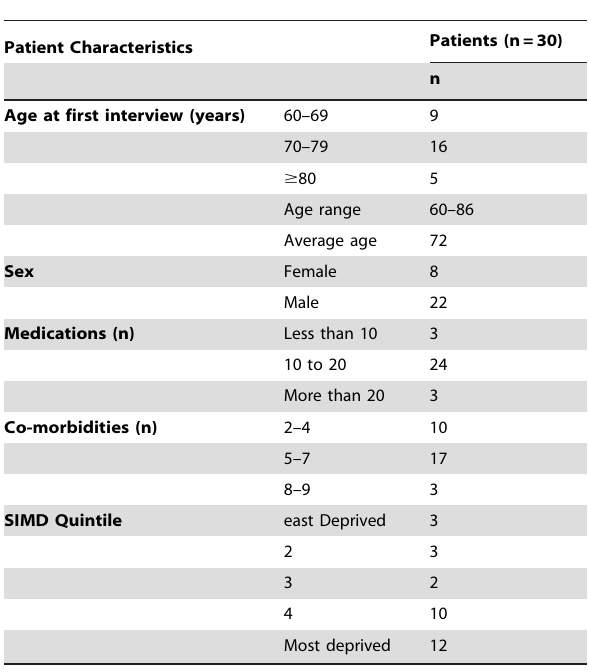
Table 2. Advanced Heart Failure Patient Participants.